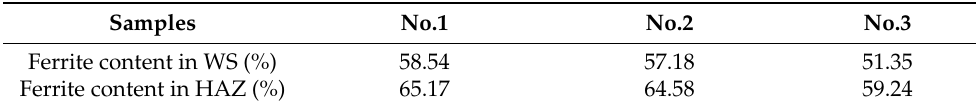
Table 2. Ferrite content of WS and HAZ in different shielding gases